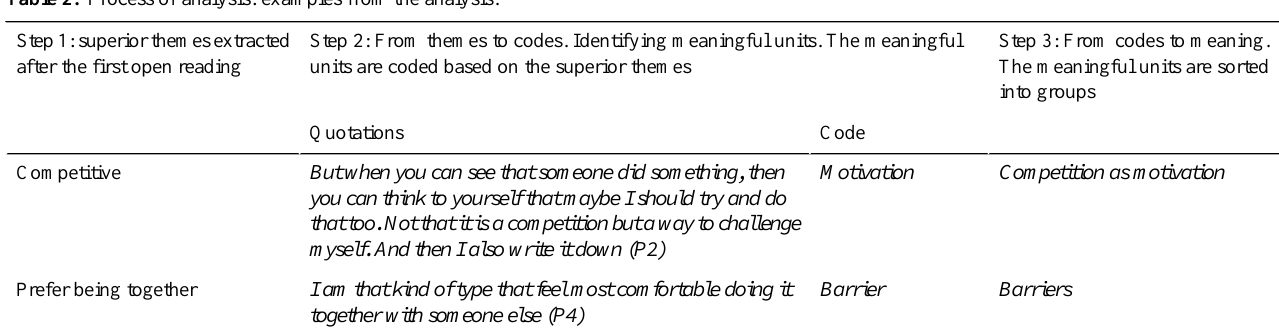
Table 2. Process of analysis: examples from the analysis.